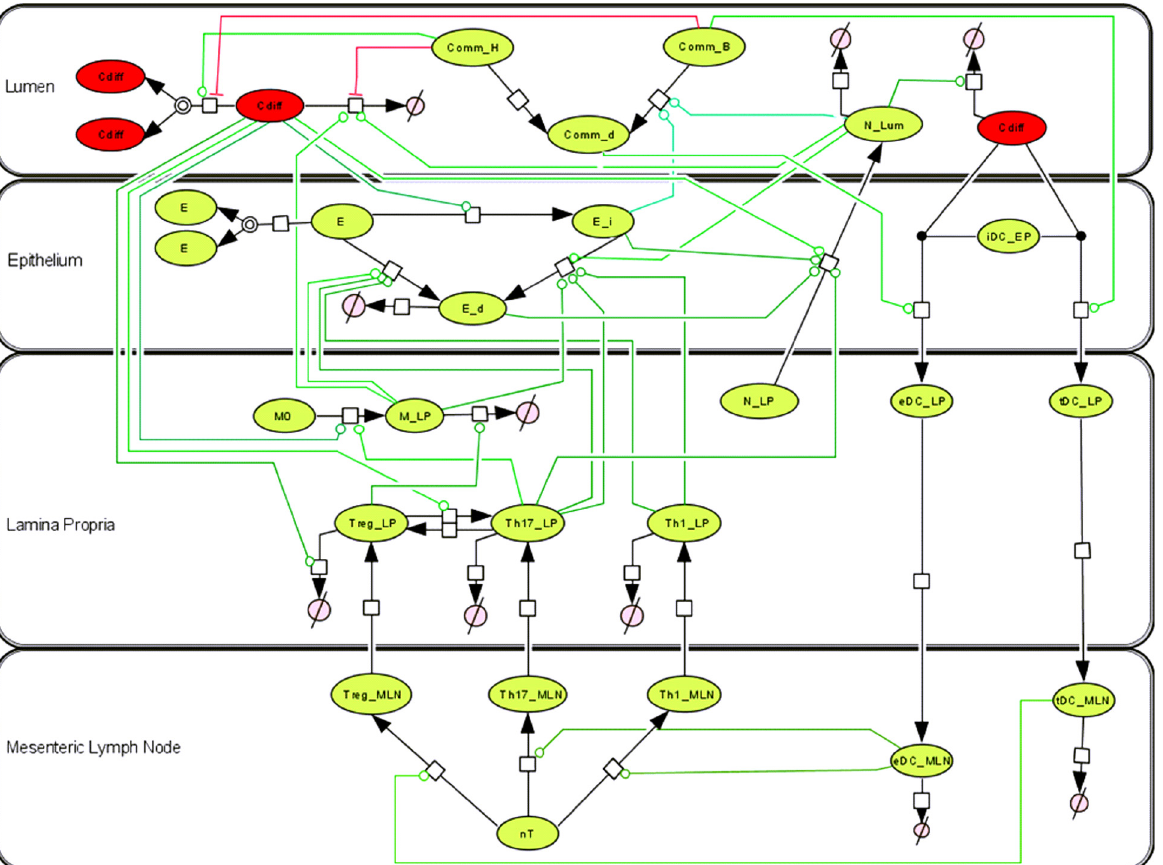
Fig 1. Network topology of model illustrating mucosal immune responses to Clostridium difficile . Systems biology markup language (SBML) compliant network of interactions between C . difficile and cellular immune components created in CellDesigner. Reaction modifiers connect cell nodes to reaction arrows with green as indication of activation and red of inhibition. Species consist of C . difficile ( Cdiff ), infection-exacerbating commensal bacteria ( CommH ), protective commensal bacteria ( CommB ), dead commensal bacteria ( CommD ), epithelial cells ( E ), inflamed epithelial cells ( E i ), neutrophils ( N ), macrophages ( M ), dendritic cells ( tDC and eDC ), T cells ( nT , Treg , Th17 , Th1 ) existing in multiple compartments lumen ( Lum ), epithelium ( EP ), lamina propria ( LP ), and mesenteric lymph node ( MLN ).